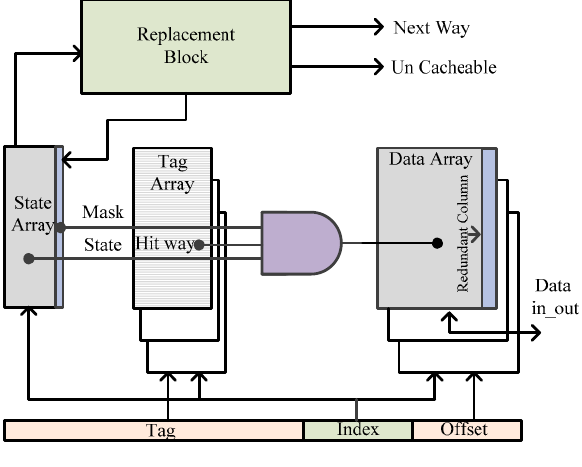
Figure 18. Runtime re-sizeable cache architecture [56].